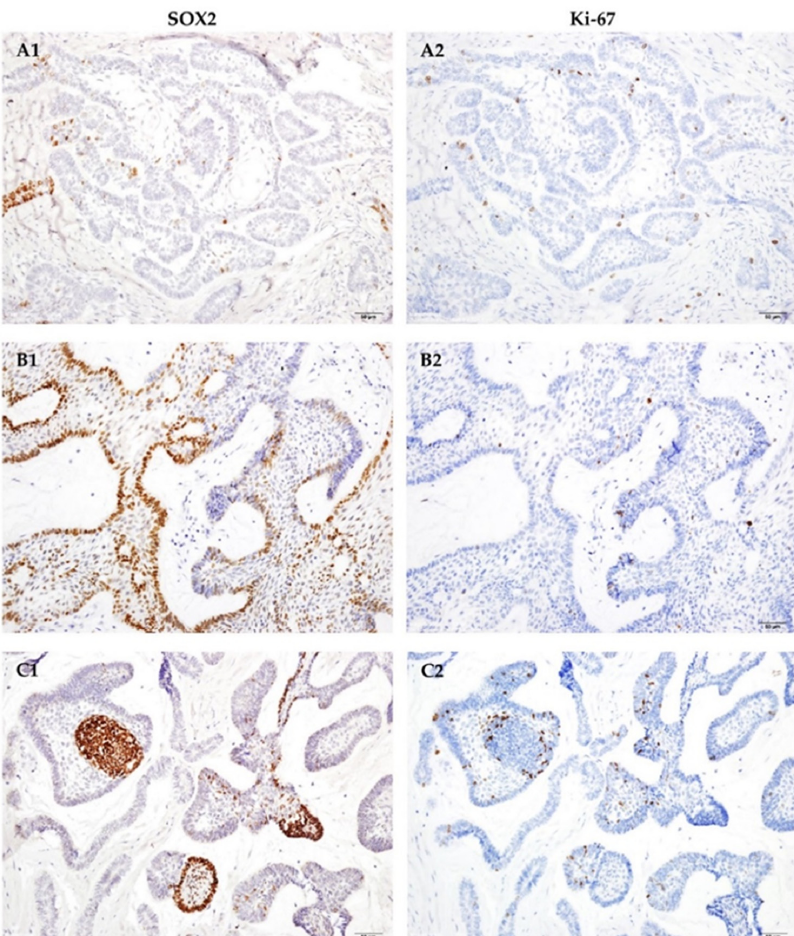
Figure 3. Comparison of the location of positive cells under SOX2 and Ki-67 immunostain. The cells show exclusively positive to one of these two antibodies. ( A ) follicular type; ( B ) plexiform type; ( C ) unicystic type, mural subtype. (Original magnification ×200). Table 3. Immunohistochemistry in three histologic patterns of ameloblastoma.